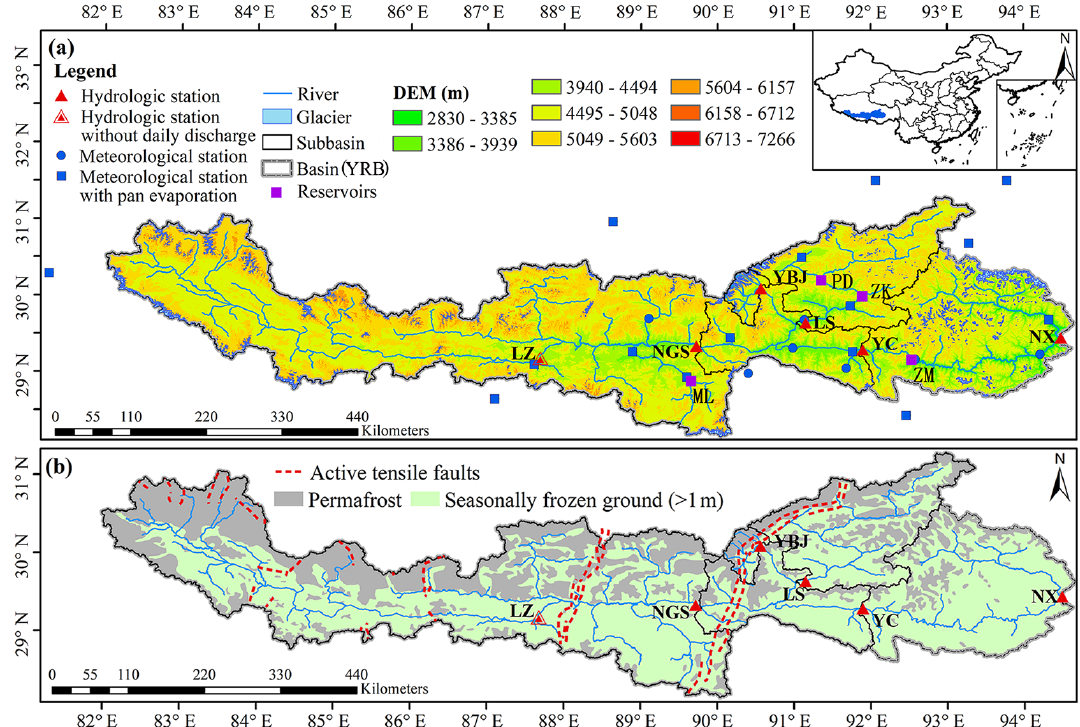
Figure 1. (a) Geographical location of the Yarlung Zangbo River basin (YRB; the entire basin is above the hydrological station of Nuxia) and its five subbasins (NGS for Nugesha, YC for Yangcun, NX for Nuxia, YBJ for Yangbajain, and LS for Lhasa) from upstream to downstream. (b) Distributions of permafrost and seasonally frozen ground in 2012 and active tensile faults (the red dotted